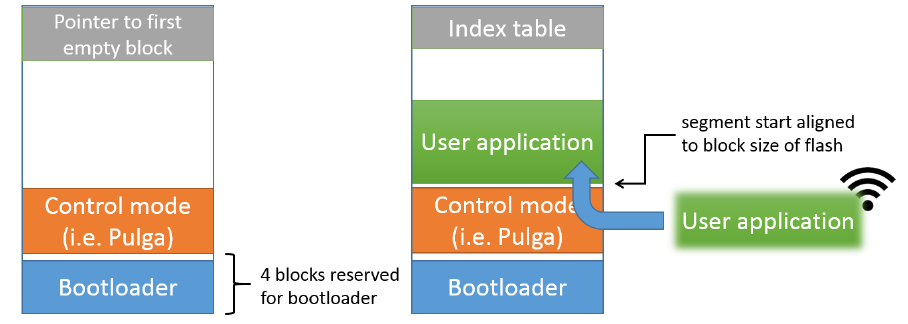
Figure 10. Flash memory